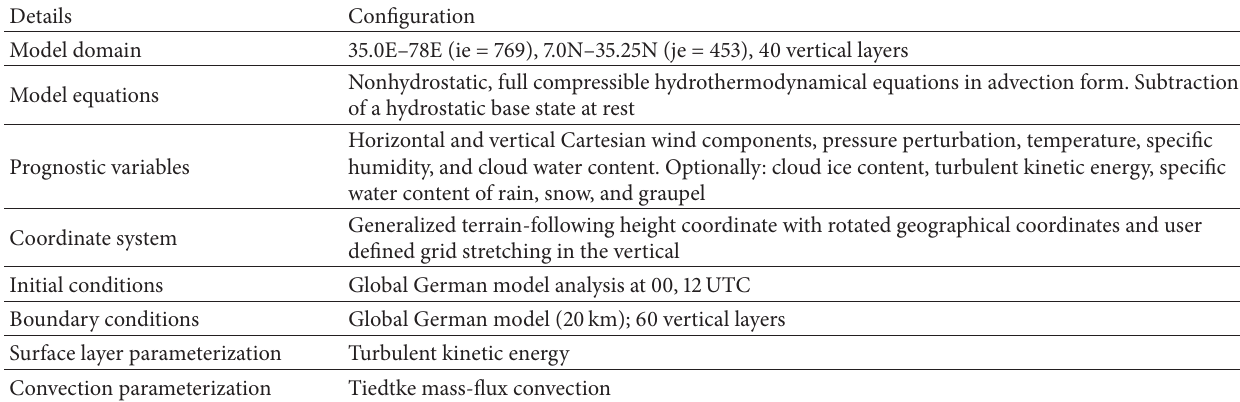
Table 1: COSMO model configuration.